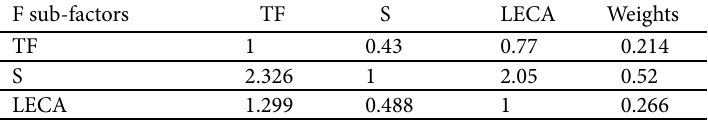
Table 8. Local weights and pairwise comparison matrix of financial sub-factors F